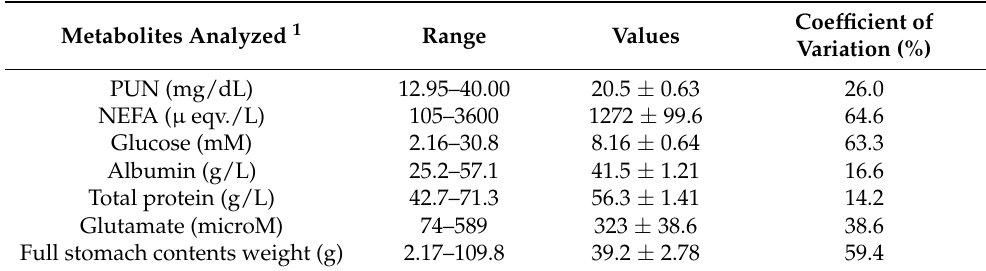
Table 1. Metabolites values (least square means ± standard errors) of the experimental population, obtained from blood samples of European wild rabbits ( Oryctolagus cuniculus